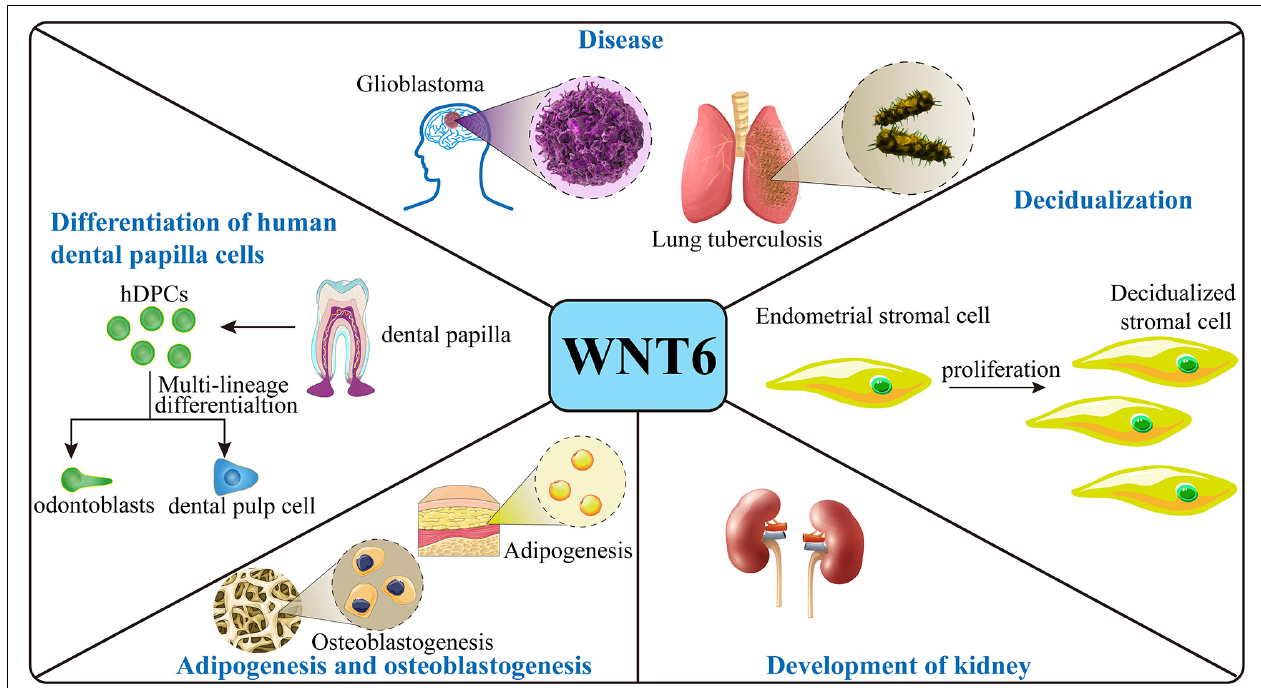
FIGURE 2 | Function of WNT6. In the mouse embryo, WNT6 is expressed and promote stromal cell proliferation during decidualization and induces pre-tubular aggregation in the mesenchyme during formation of the renal tubule. WNT6 also prevents adipogenesis and stimulates osteoblastogenesis in mice. With respect to disease, in mice, loss of WNT6 correlates with the development of kidney fibrosis, and WNT6 can maintain the integrity of epithelium. WNT6 expression promotes the development of lung tuberculosis and GBM. In human cell models, WNT6 expression promotes the differentiation and migration of hDPCs and promotes the formation and development of